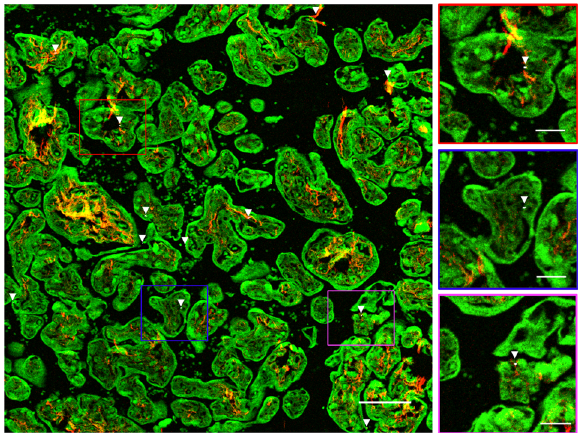
Fig. 2 Evidence of BC particles at the fetal side of the human placenta. WL generation originating from the BC particles (white and further indicated using white arrowheads) under femtosecond pulsed laser illumination (excitation 810 nm, 80 MHz, 10 mW laser power on the sample) is observed. Second harmonic generation from collagen (red, emission 400 – 410 nm) and TPAF from placental and red blood cells (green, emission 450 – 650 nm) are simultaneously detected. Scale bar: 100 µ m. The boxes on the right show the black carbon particles present in placental